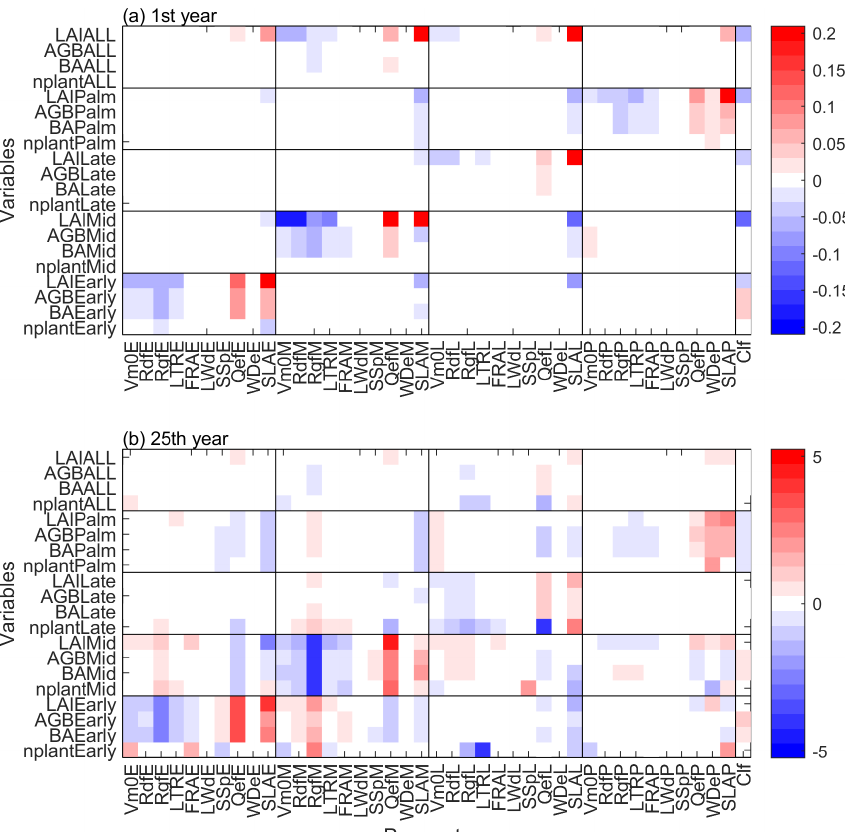
Figure 7. The standardized cubic regression coefficient ( β ) of variables at (a) first and (b) 25th year of the simulations regarding the parameters. The variables include stem density (nplant), basal area (BA), aboveground biomass (AGB), and leaf area index (LAI) for each PFT. The parameters include 10 PFT-dependent parameters and one PFT-independent parameter listed in Table 1.